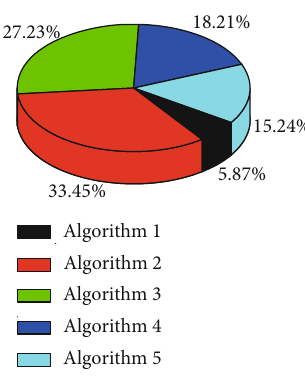
Figure 10: Comparison of the e ff ects of urban planning image enhancement algorithms based on partial di ff erential